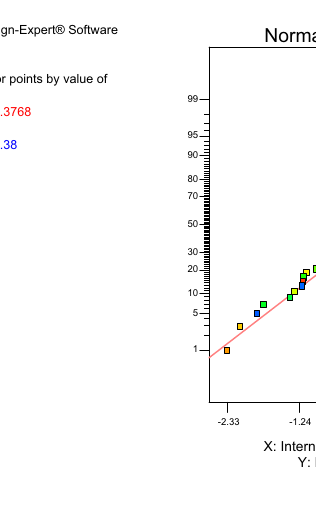
Figure 11: ( a ) Normal vs residual probability plot of SR and ( b ) predicted vs actual response values graph for SR.